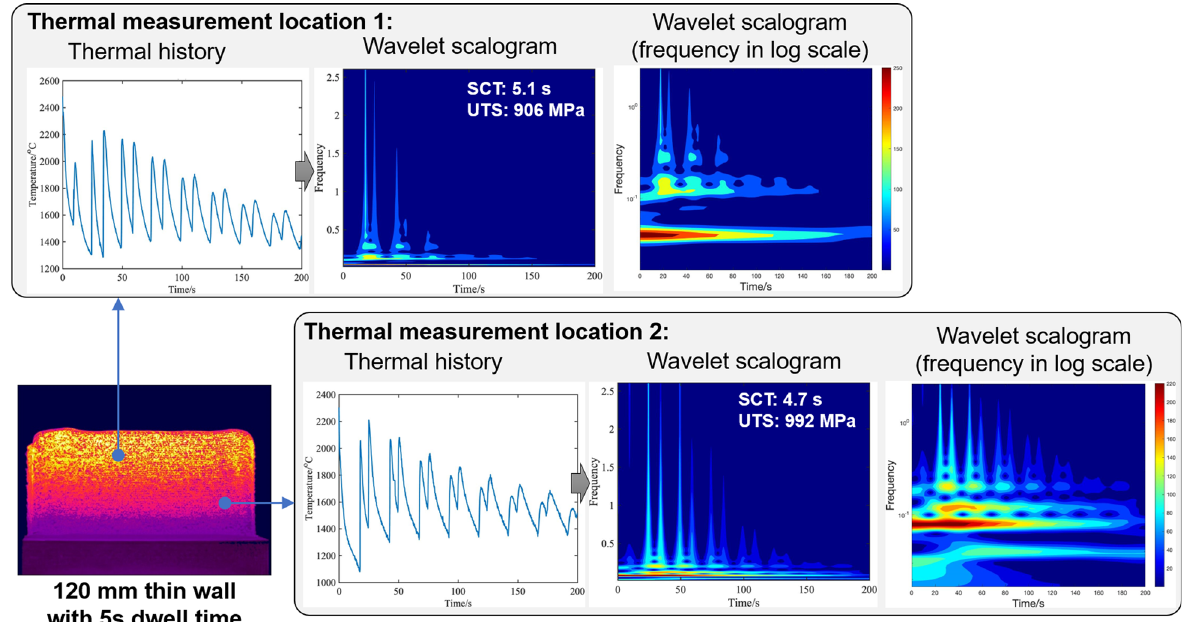
Fig. 6 Thermal histories and corresponding wavelet scalograms on the thin wall with 5 s dwell time. They are obtained at different thermal measurement locations. SCT indicates solidi fi cation cooling time and UTS indicates ultimate tensile